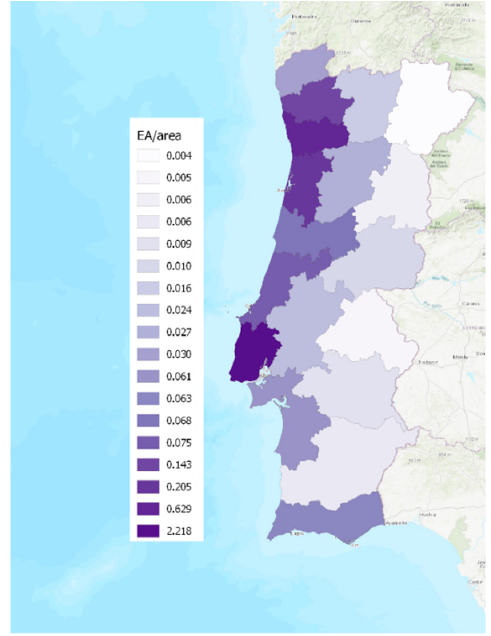
Figure 11. EAM per density (km 2 ) (map elaborated with QGIS).